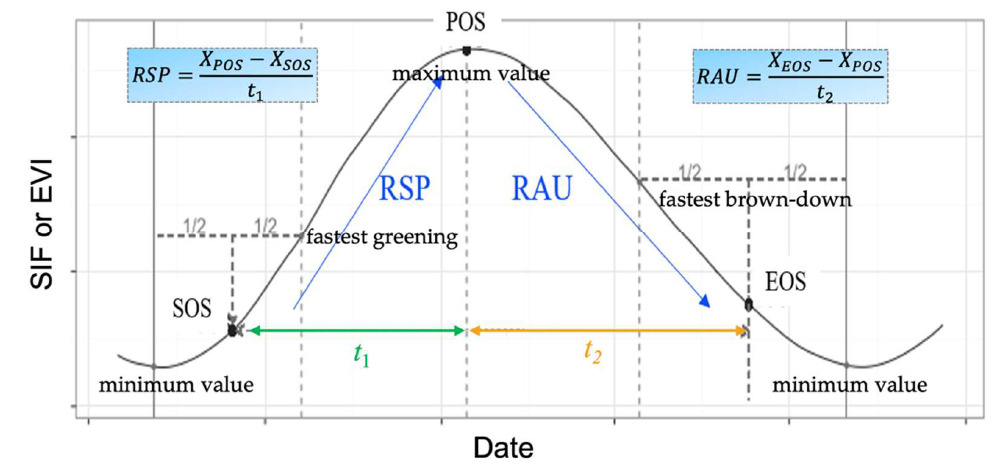
Figure 2. Schematic diagram of phenological metrics’ retrieval. The curve refers to the seasonal SSA-re-reconstructed EVI or SIF profile at a daily scale. SOS: the start of the growing season; POS: the peak of the growing season; EOS: the end of the growing season; RSP: the rate of spring green-up; RAU: the rate of autumn senescence.